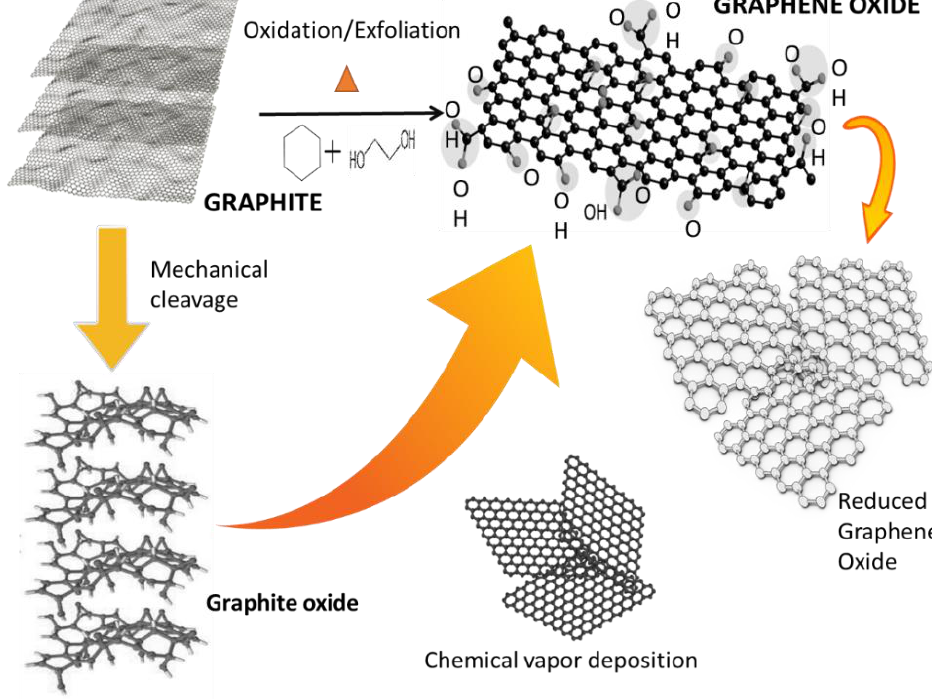
Figure 8. Theoretical models of the structure of graphite or graphene oxide [31].